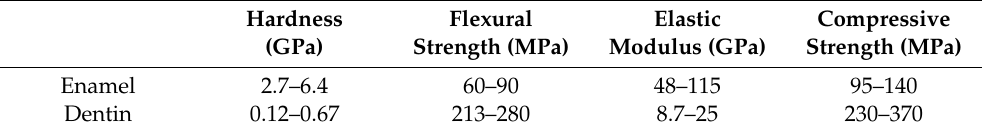
Table 1. The mechanical properties of natural human teeth [20–23].